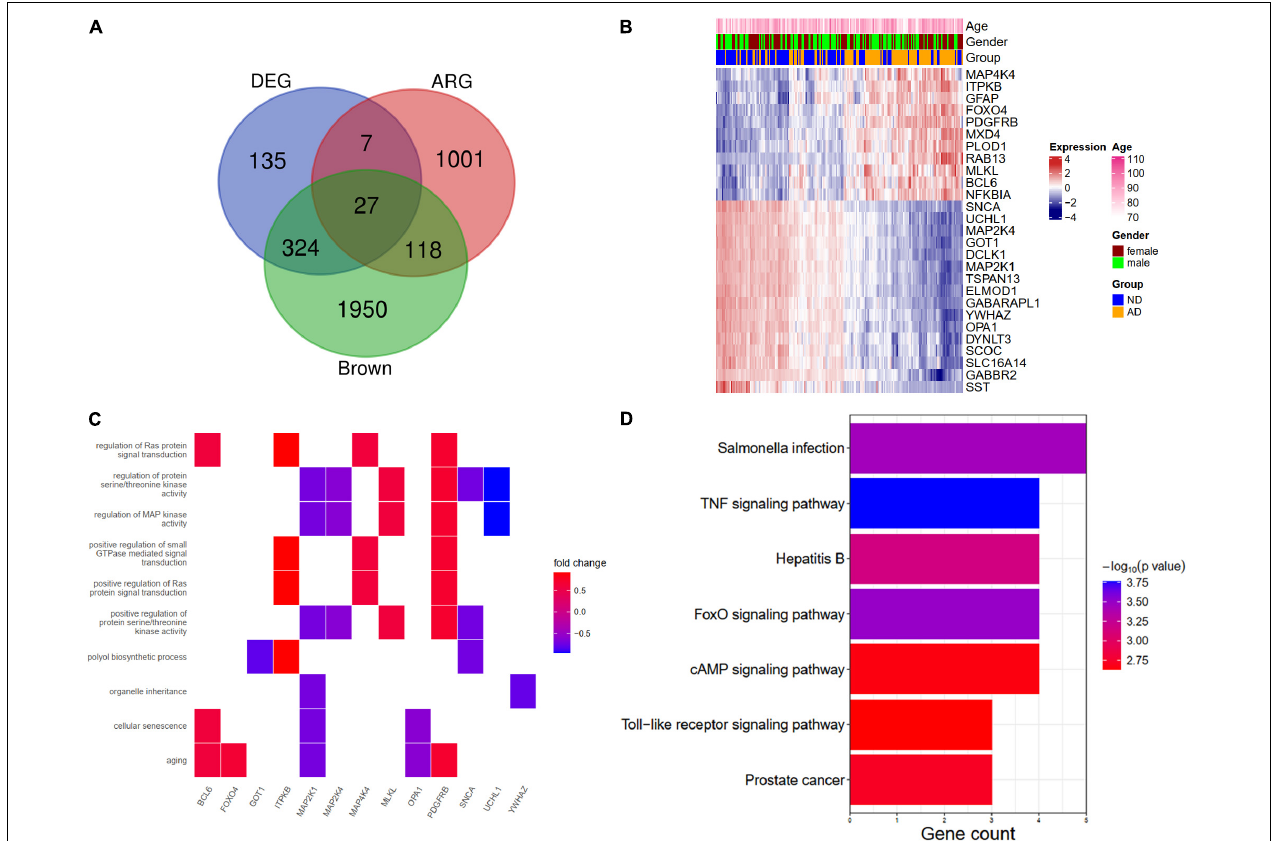
FIGURE 5 | Identification and functional enrichment analysis of aging-related DEGs (ARDEGs). (A) Identification of ARDEGs with a venn diagram. (B) A heat map showing the expression of ARDEGs. (C) A heat map showing the biological processes and related ARDEGs. (D) KEGG pathways of